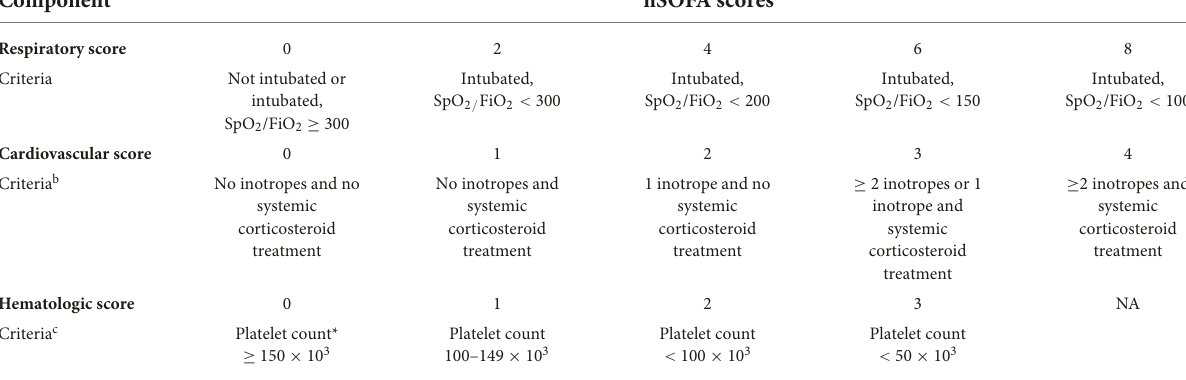
TABLE 1 Neonatal sequential organ failure assessment (nSOFA) components and scoring.